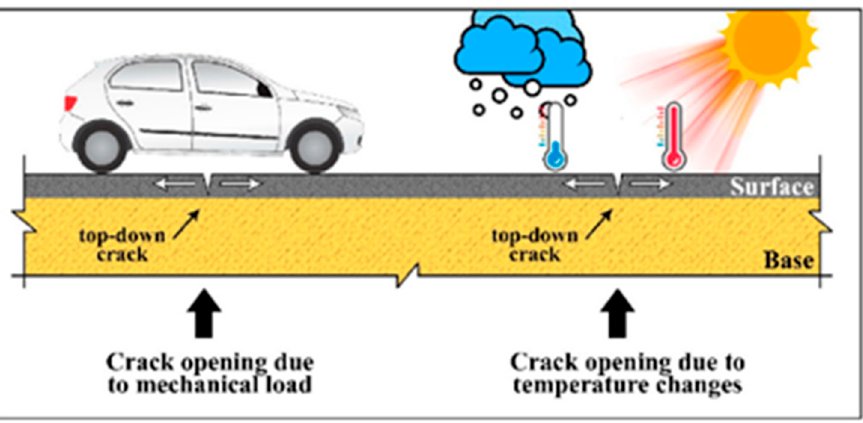
Figure 1. Pavement cracking.